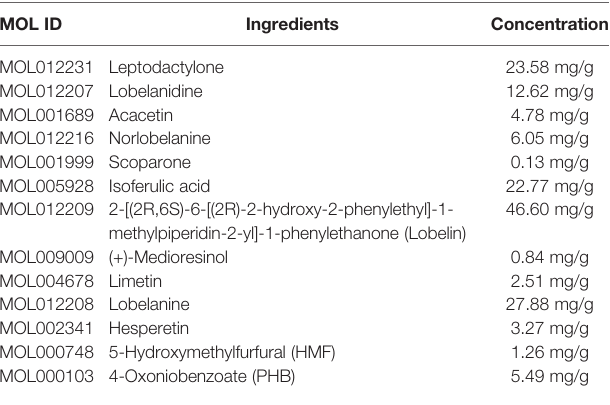
TABLE 1 | The concentration of the active ingredients of Lobelia chinensis . MOL ID